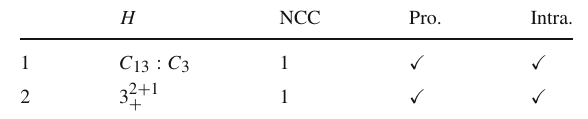
Table 9 The π -submaximal subgroups of S = L 3 ( 3 ) . Case: π ∩ π( S ) = { 3 , 13 } . In any cases